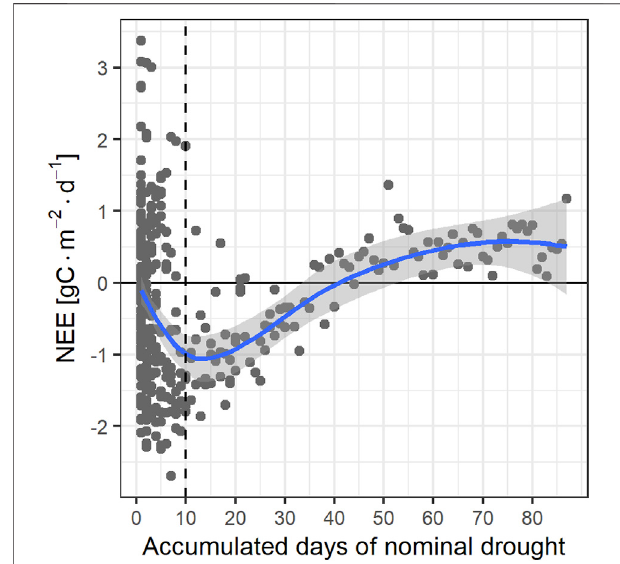
FIGURE 6 | Relationship between carbon fl uxes and accumulated days of nominal drought (de fi ned as precipitation < 5 mm/day).